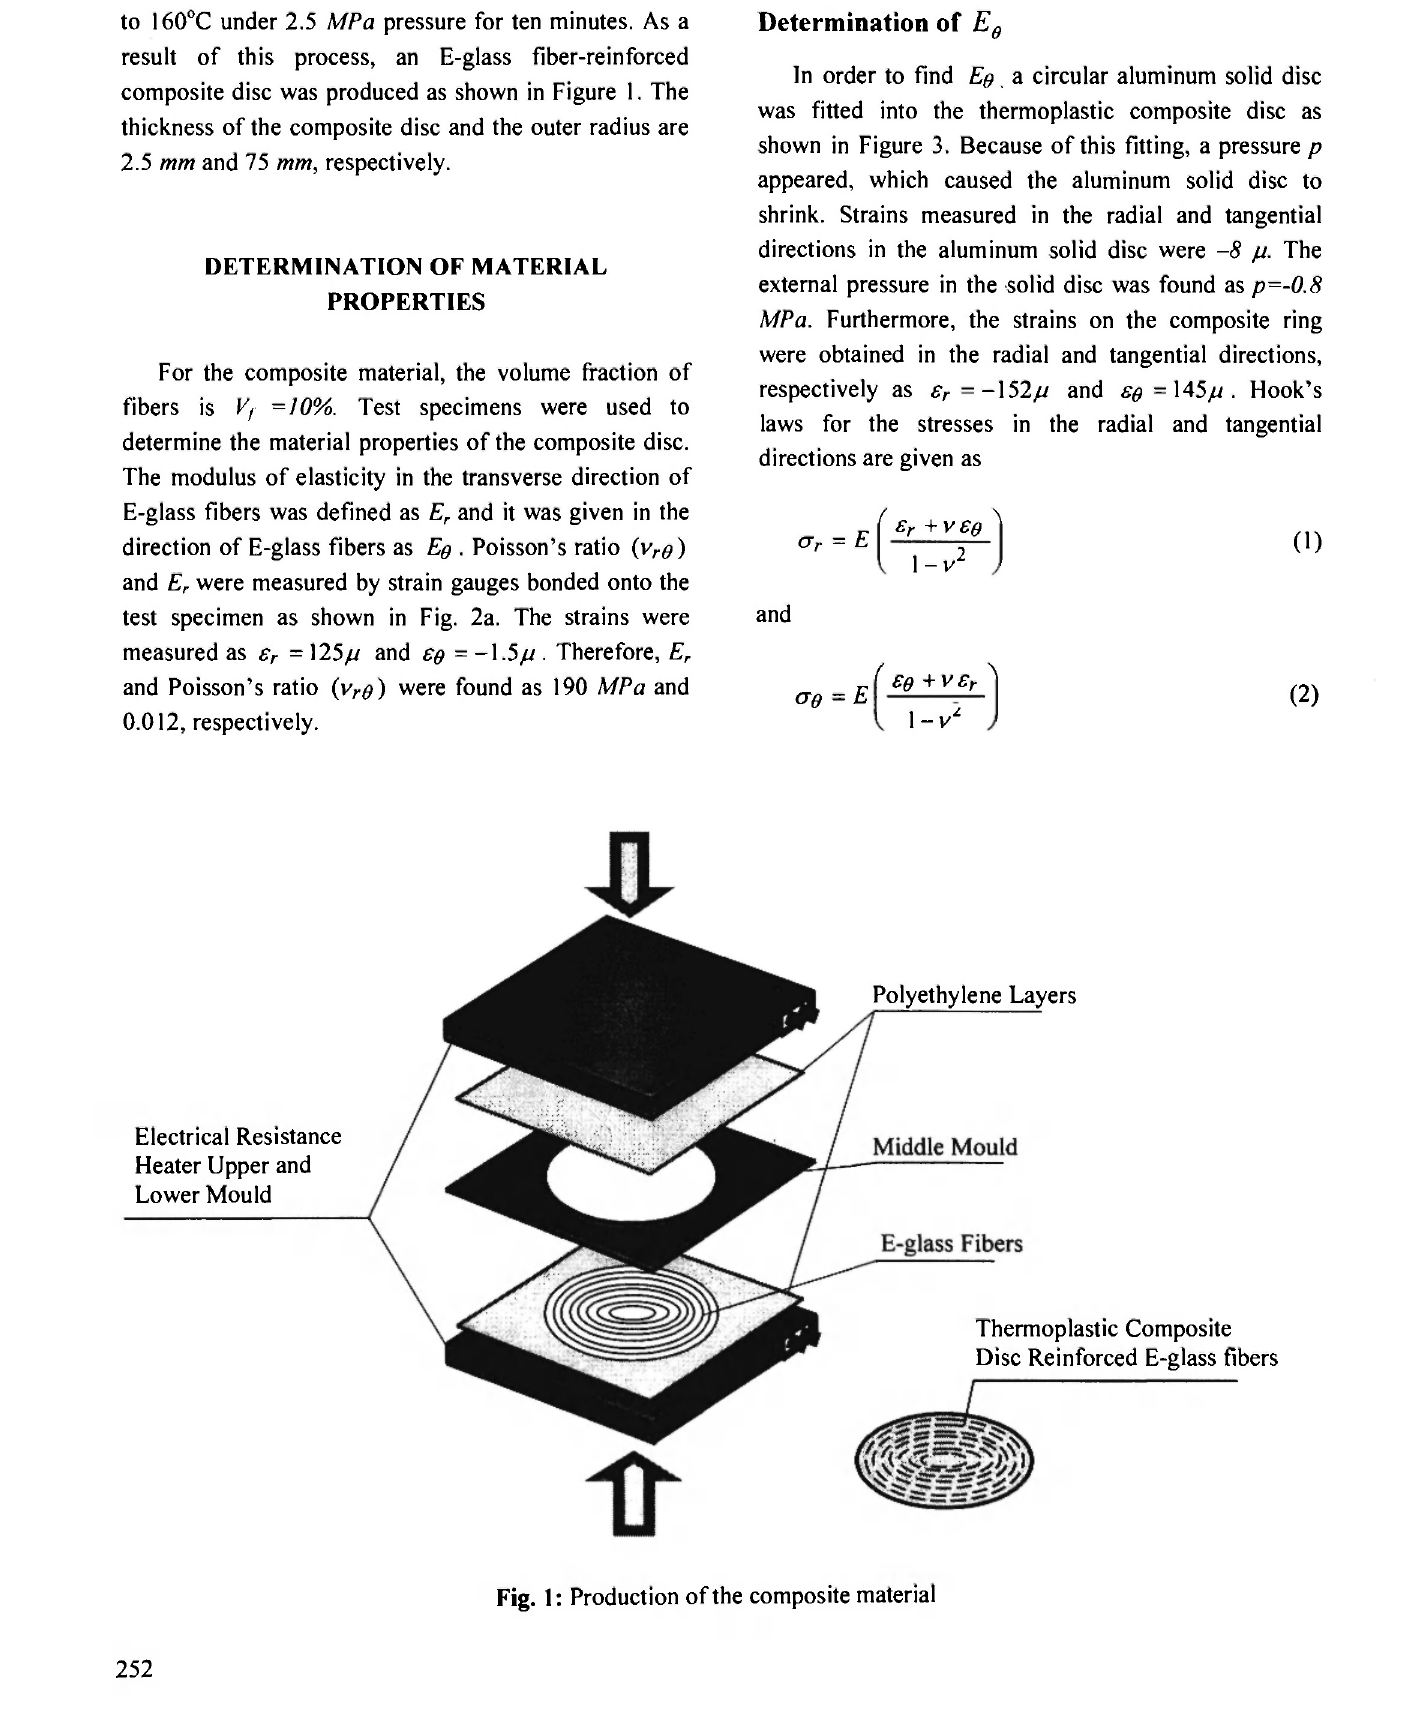
Fig. 1: Production of the composite